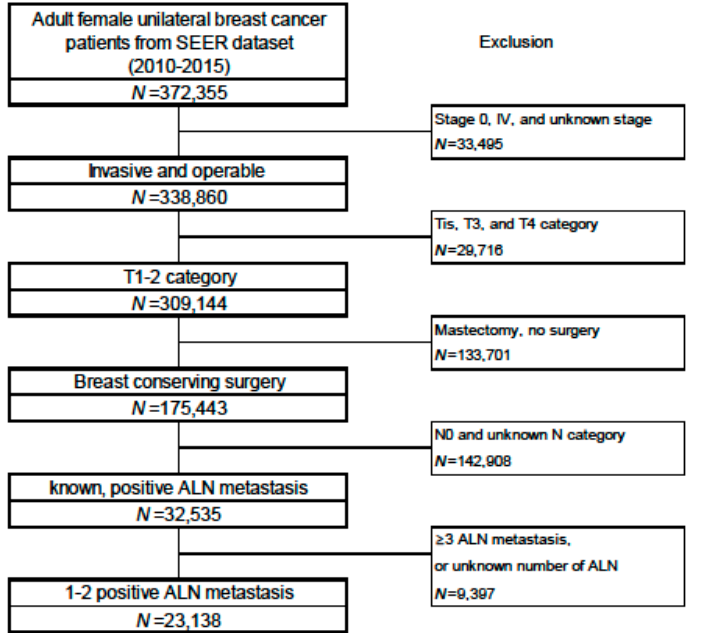
Figure 4. Subject selection process from the SEER database. Abbreviations: axillary lymph node (ALN).